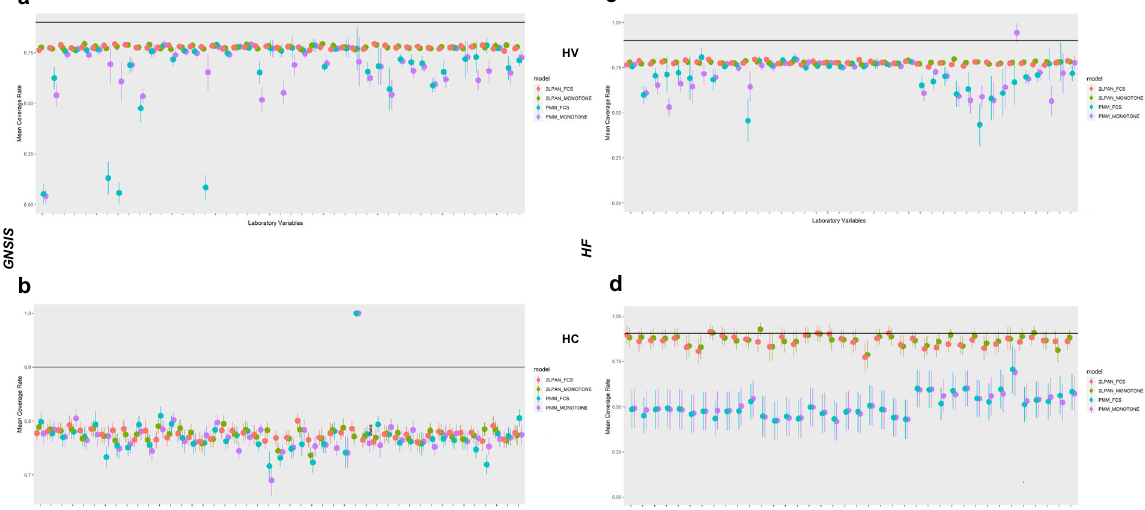
Fig. 4 Mean coverage rate (CR) across all imputation algorithms evaluated for GNSIS and HF datasets. The vertical bar represents 95%CI of the corresponding mean imputed value for 50 holdouts. The horizontal line represents the mean coverage rate of 0.90. a / b represents CR for 50 holdout values (HV) or complete cases (HC), respectively, in GNSIS; c / d represents CR for 50 HV or HC, respectively, in